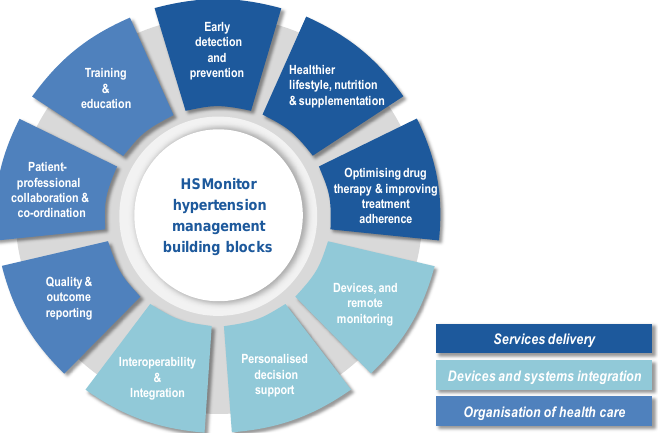
Figure 1. Building blocks in the HSMonitor framework. Int. J. Environ. Res. Public Health 2021 , 18 , x FOR PEER REVIEW